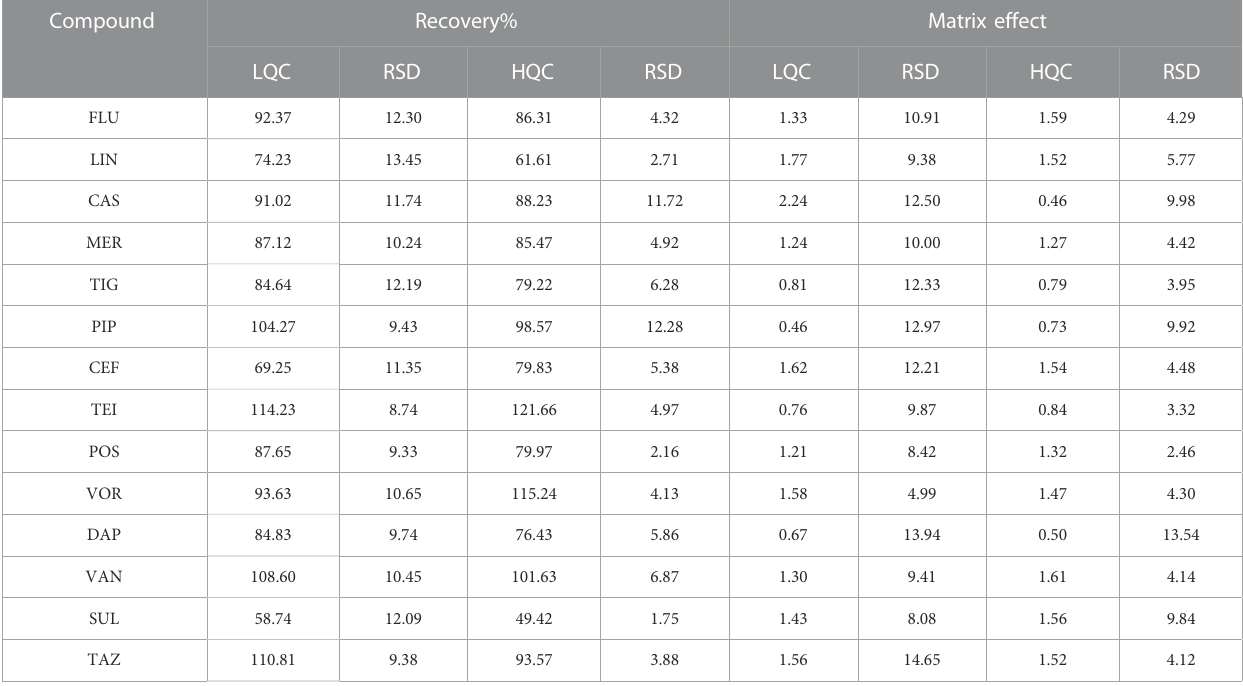
TABLE 3 Extraction recovery and matrix effect of the developed method. Compound